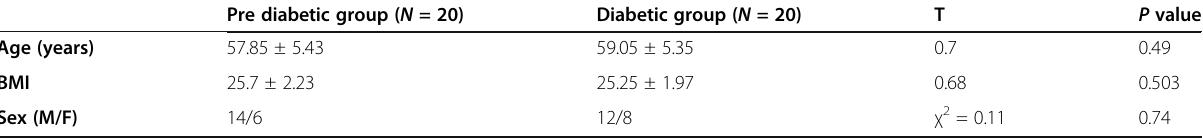
Table 1 Comparison between the two studied groups according to demographic data Pre diabetic group ( N = 20)